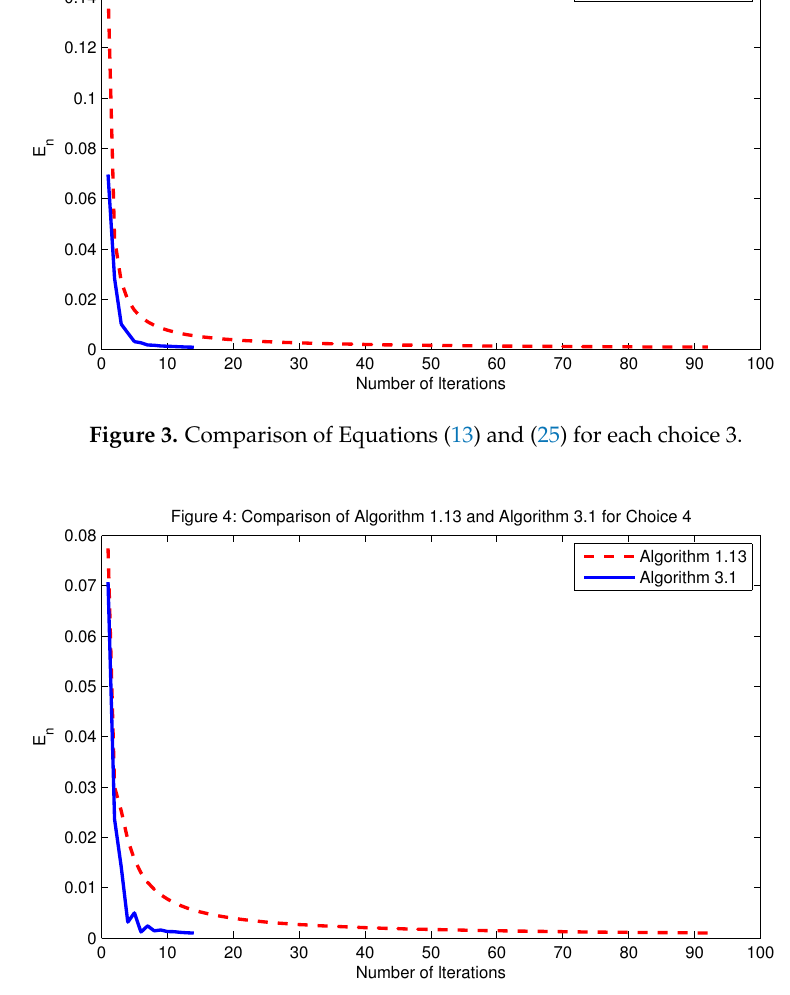
Algorithm 1.13 Algorithm 3.1